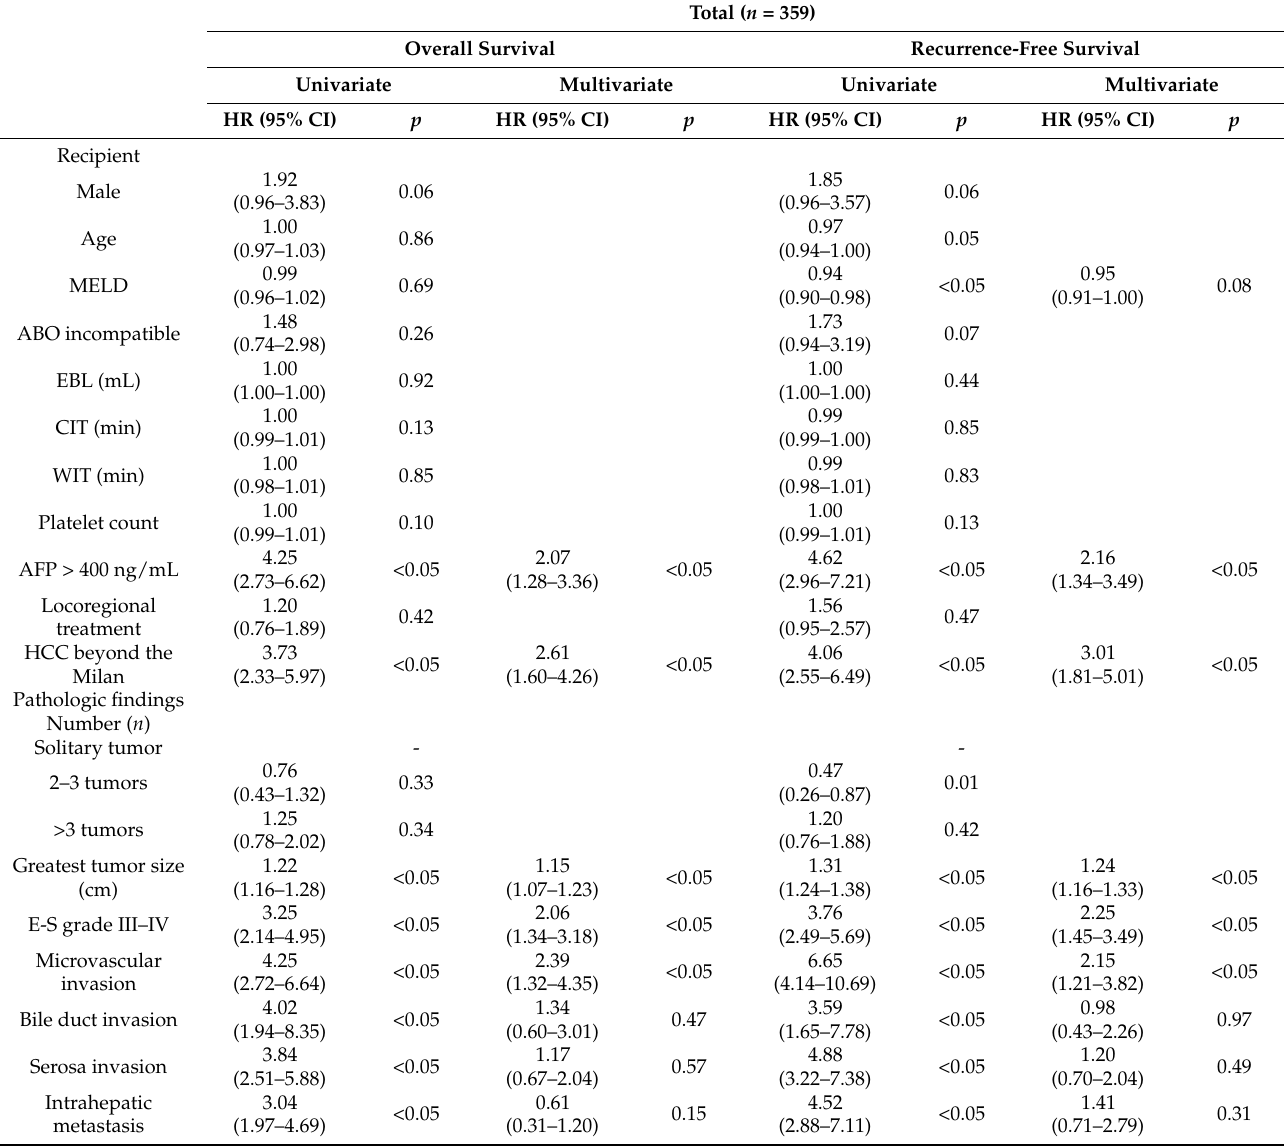
Table 3. Univariate and multivariate analyses for overall and recurrence-free survivals in the total patient population. Total ( n = 359) Overall Survival Recurrence-Free Survival Univariate Multivariate Univariate